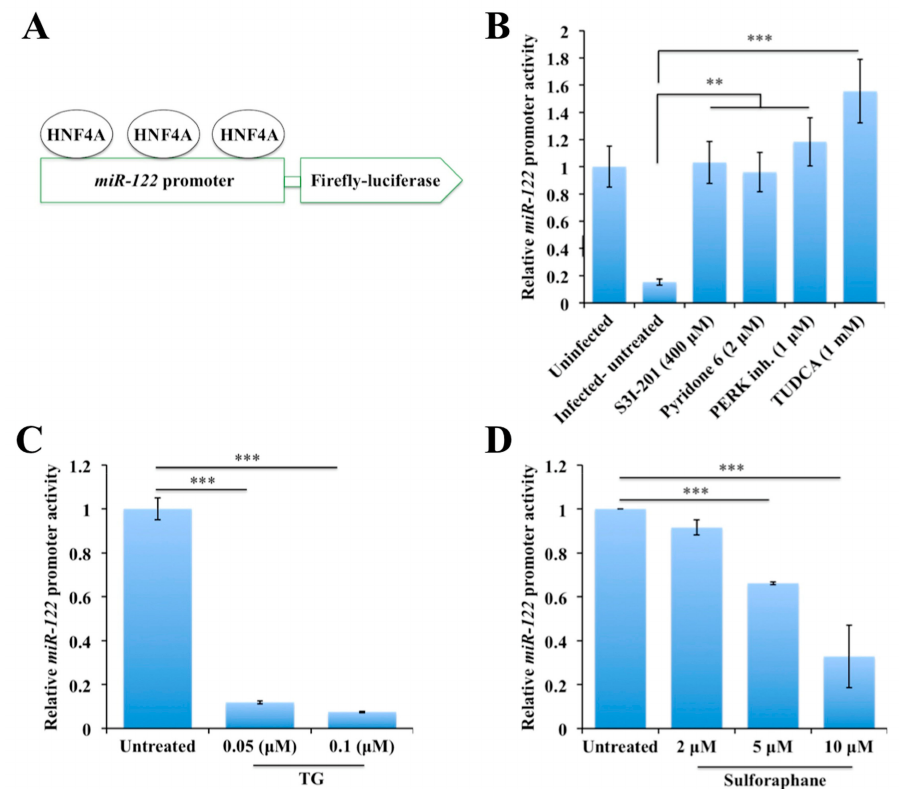
Figure 6. The impact of endoplasmic reticulum (ER) stress on the miR-122 promoter activity. ( A ) There are three hepatocyte nuclear factor 4 alpha (HNF4A) binding sites present in miR-122 promoter, which explain why HNF4A downregulation decreases miR-122 under stress. ( B ) The e ff ect of small molecule inhibitors targeted to signal transducer and activator of transcription 3 (STAT3), Janus kinase 1 (JAK1), protein kinase RNA-like ER kinase (PERK) and ER stress on the miR-122 promoter regulation. Uninfected and hepatitis C virus (HCV)-infected Huh-7.5 cells were transfected with one microgram of miR-122 promoter-construct with firefly luciferase. Following the transfection step, cells were treated with or without thapsigargin (TG), sulforaphane, and STAT3 inhibitors. After 24 hours, the luciferase activity was measured. Luciferase assays were performed three times. ( C ) ER stress activator regulation of miR-122 promoter. ( D ) The impact of a nuclear factor erythroid 2-related factor 2 (NRF2) activator, sulforaphane, on miR-122 promoter activity. The results are expressed as the mean ± standard deviation (SD) of three experiments. Error bars represent SD. p -values were calculated by ANOVA between di ff erent groups as compared to untreated HCV-infected group. ** p -value < 0.01, *** p -value <